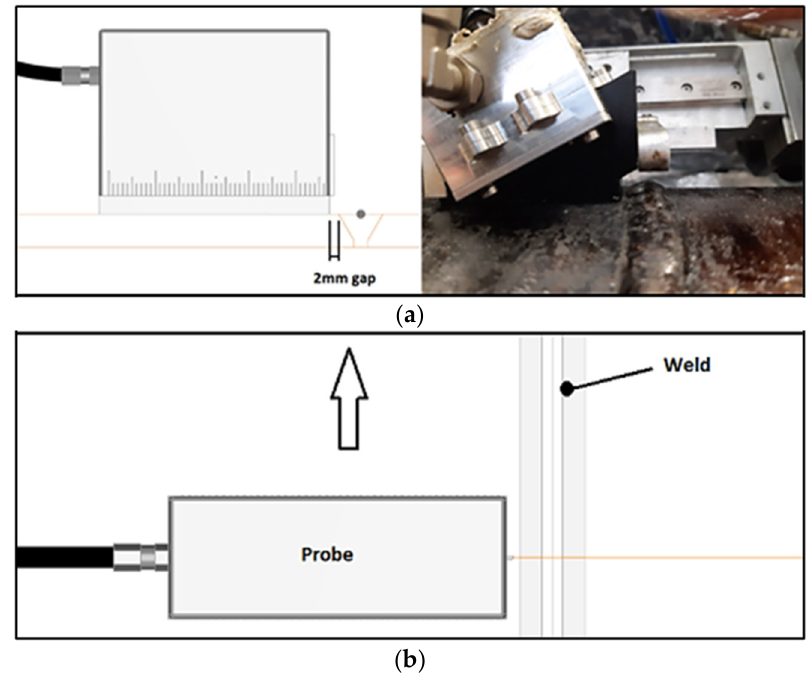
Figure 6. Scan plan. ( a ) Probe position; ( b ) Probe movement.